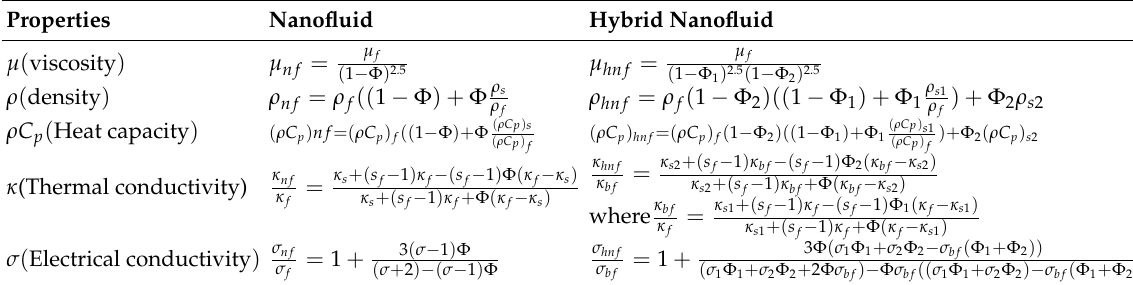
Table 3. Thermo-physical properties of hybrid nanofluid